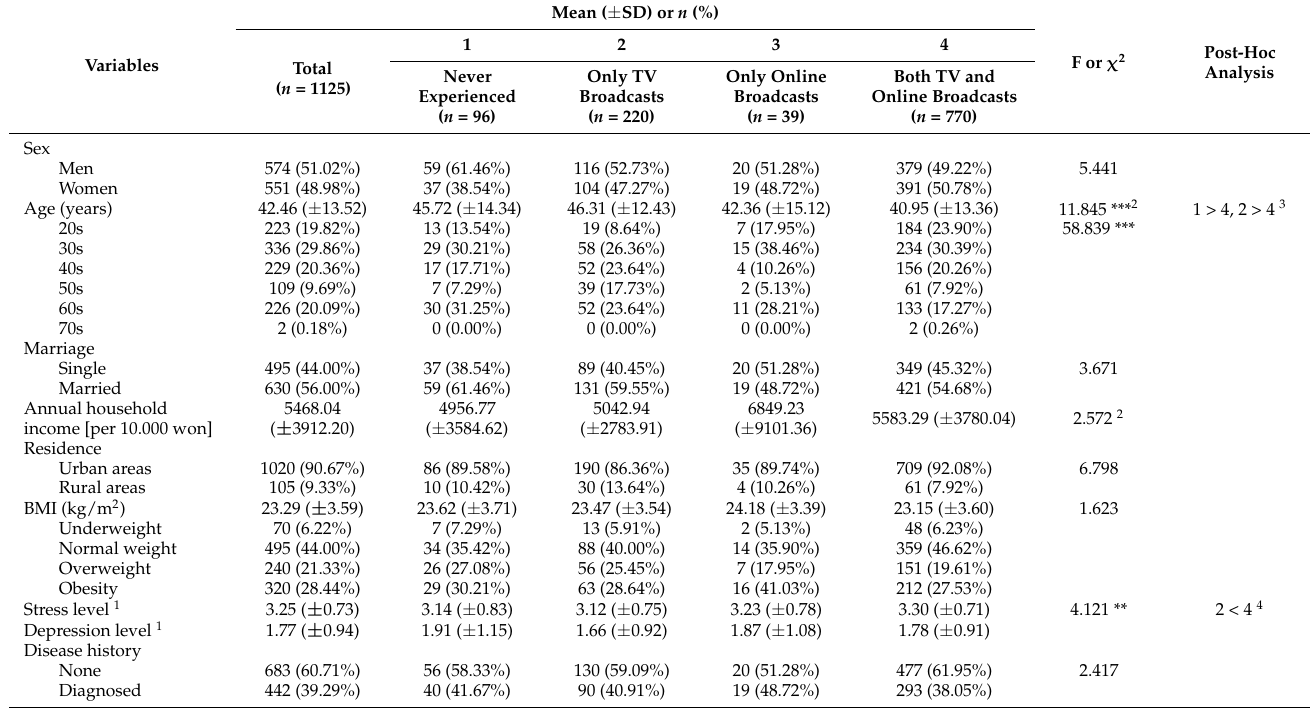
Table 1. Sociodemographic characteristics and health status for study variables by eating broadcast viewing